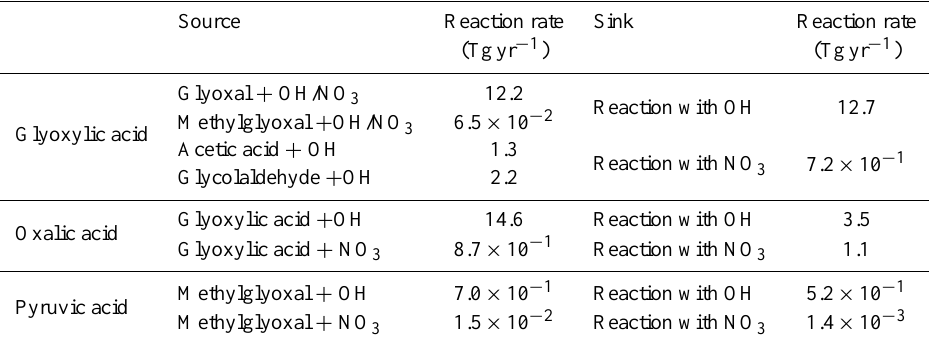
Table 3. Predicted global average production rates in cloud water by the individual reactions for Case 1 ∗